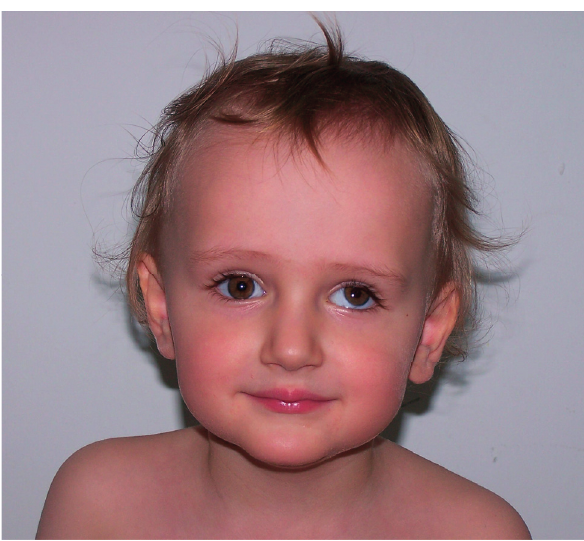
Fig. 4. Facial features of patient AB (with NFIX mutation). Fig. 5. Integrative Genomics Viewer view of NFIX mutation in patient AB by next-generation sequencing – c.367C>T in exon 2 (34/64 reads). ity with aggressive and self-injurious behavior.